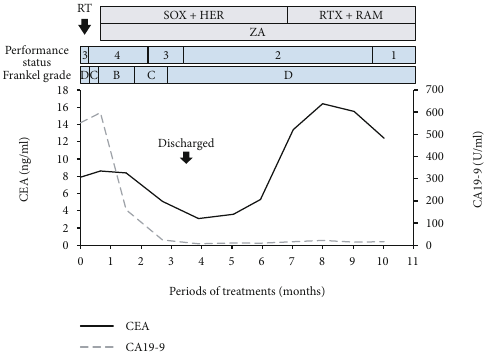
Figure 3: Changes in carcinoembryonic antigen (CEA) levels, carbohydrate antigen 19-9 (CA19-9) performance status (PS), and Frankel grade during treatment with the fl ow chart of radiotherapy and chemotherapy. First-line and second-line chemotherapy included 9 courses of SOX-HER with ZA and 4 courses of PTX- RAM with ZA, respectively. RT: radiation therapy (single 8Gy fraction); SOX: tegafur/gimeracil/oteracil (40mg/m 2 /day for 2 weeks, followed by 1 week of no medication)+oxaliplatin (130mg/m 2 every 3 weeks); HER: trastuzumab (6mg/kg every 3 weeks); PTX: paclitaxel (80mg/m 2 every 2 weeks); RAM: ramucirumab (8mg/kg every 2 weeks); ZA: zoledronic acid (4mg every 4